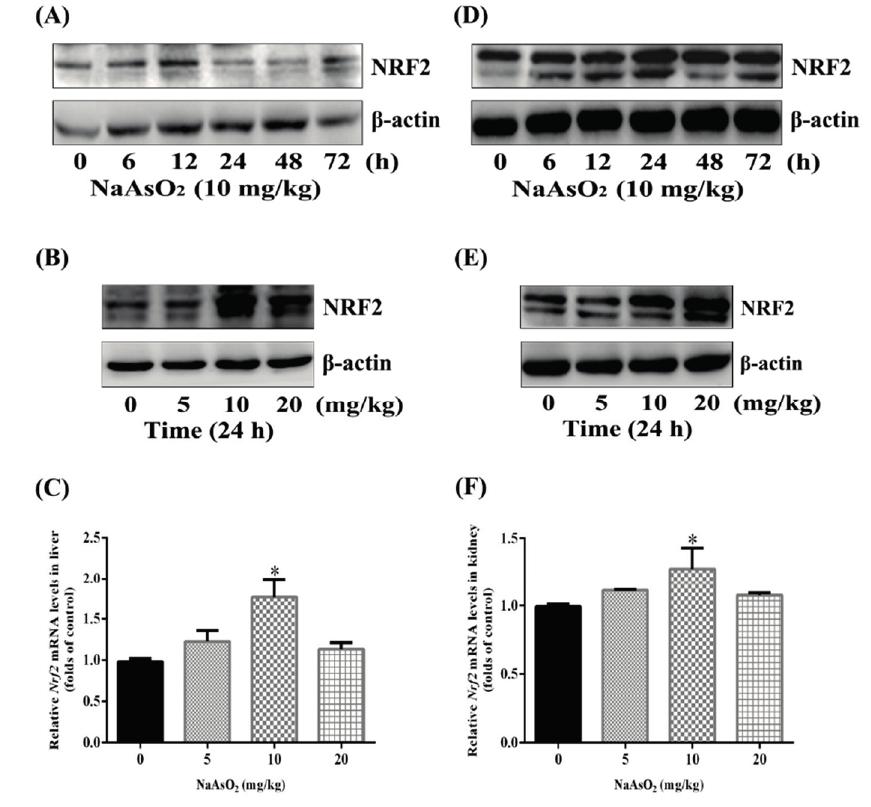
Figure 1. Up-regulation of NRF2 both in the liver and kidney of control and acute arsenic- exposed mice. Mice were treated with 0, 5, 10 and 20 mg/kg NaAsO 2 intra-gastrically for 6, 12, 24, 48 and 72 h. The extracted proteins of liver and kidney were subjected to SDS-PAGE. Expression of NRF2 protein in the liver ( A, B ) and kidney ( D, E ) of mice were assessed by western blotting. β -Actin was blotted as the loading control. Total RNA of liver and kidney from each 6 h experimental group were isolated and real-time PCR were conducted. The mRNA levels of Nrf2 in the liver and kidney were shown as ( C ) and ( F ). Results were expressed as mean ± SD (n = 4), and independent experiments were carried out three times. * denotes p < 0.05 compared with control